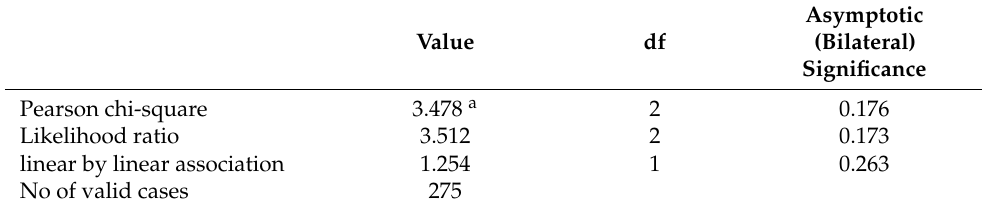
Table 10. Chi-square tests: remote work and